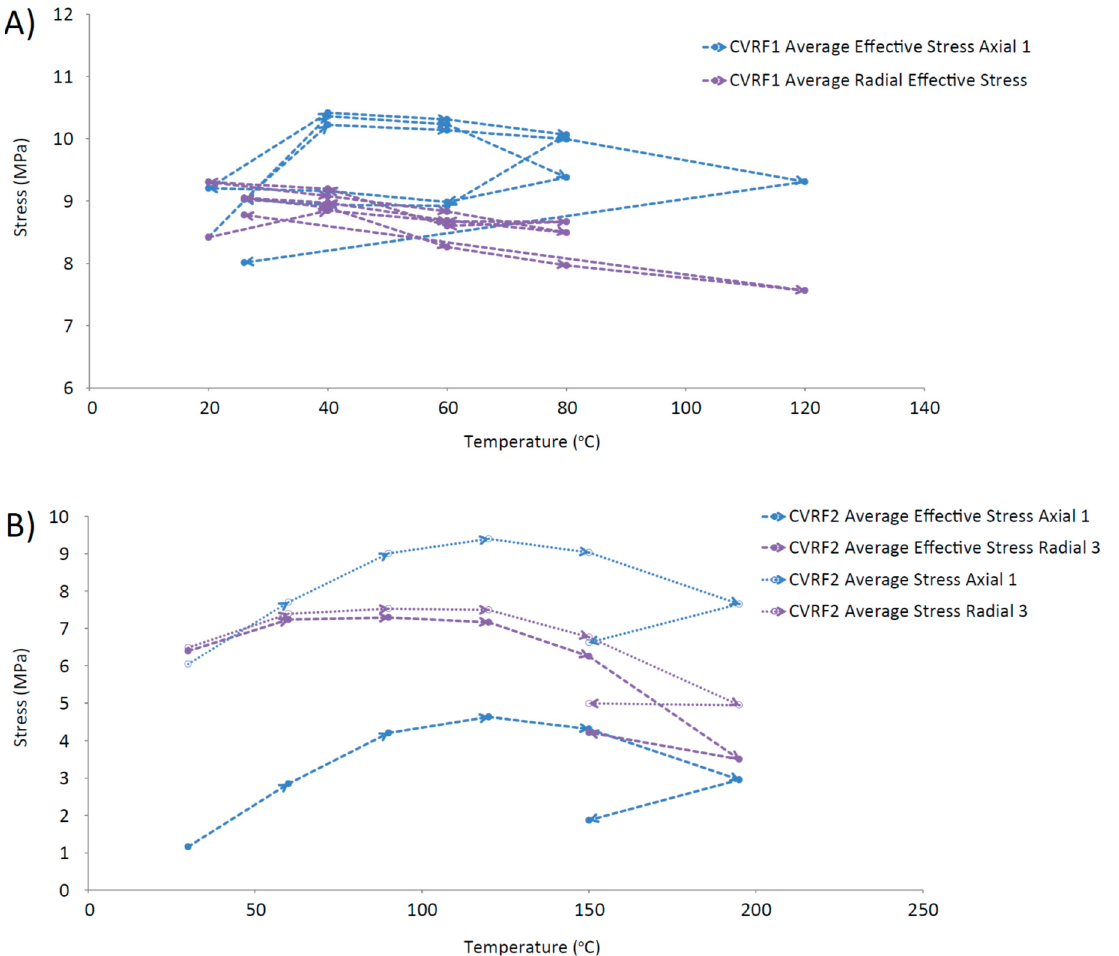
Figure 12. Average effective stress vs. temperature. ( A ) CVRF-1 experiment; ( B ) CVRF-2 experiment; here average stress vs. temperature is also plotted because the porewater pressure transducer data is regarded as unreliable. A general trend for decreasing average effective stress with increasing temperature is observed.